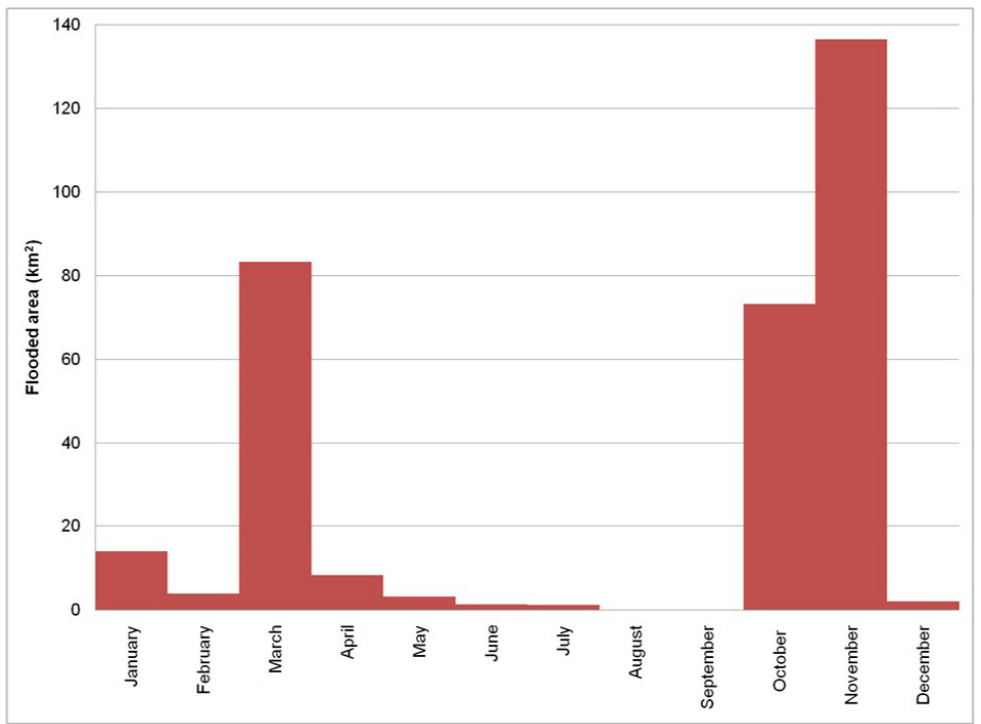
Figure 7. The monthly distribution of the flooded area during